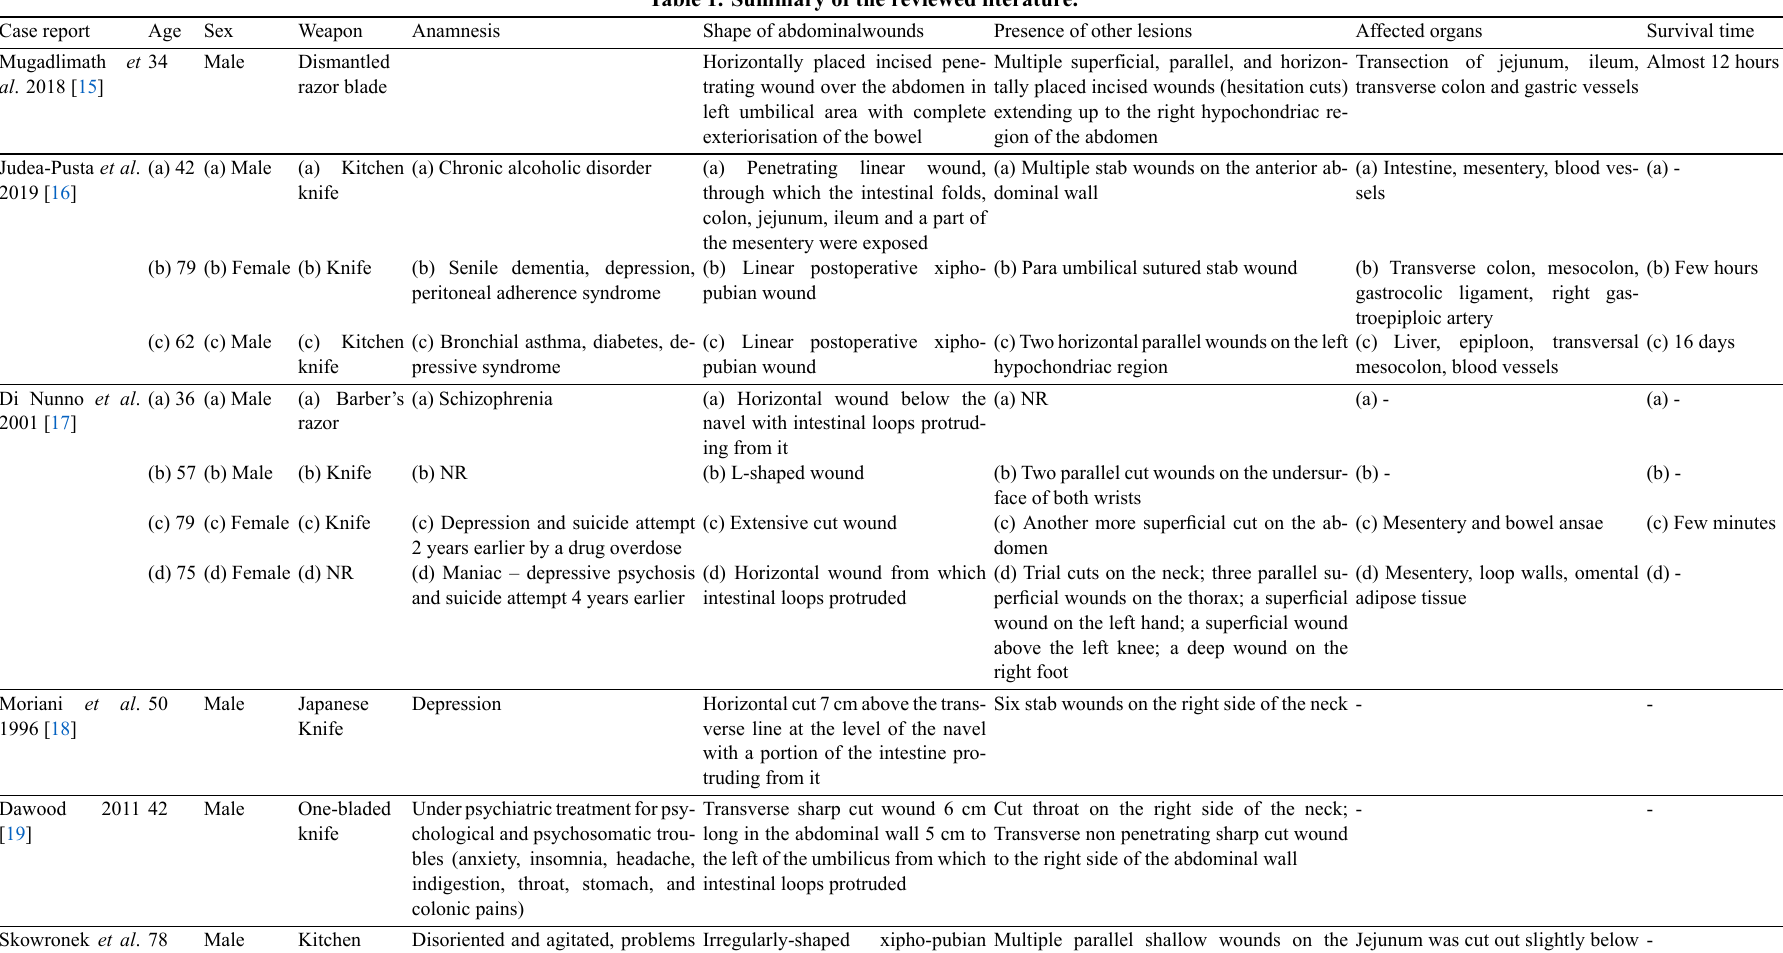
Table 1. Summary of the reviewed